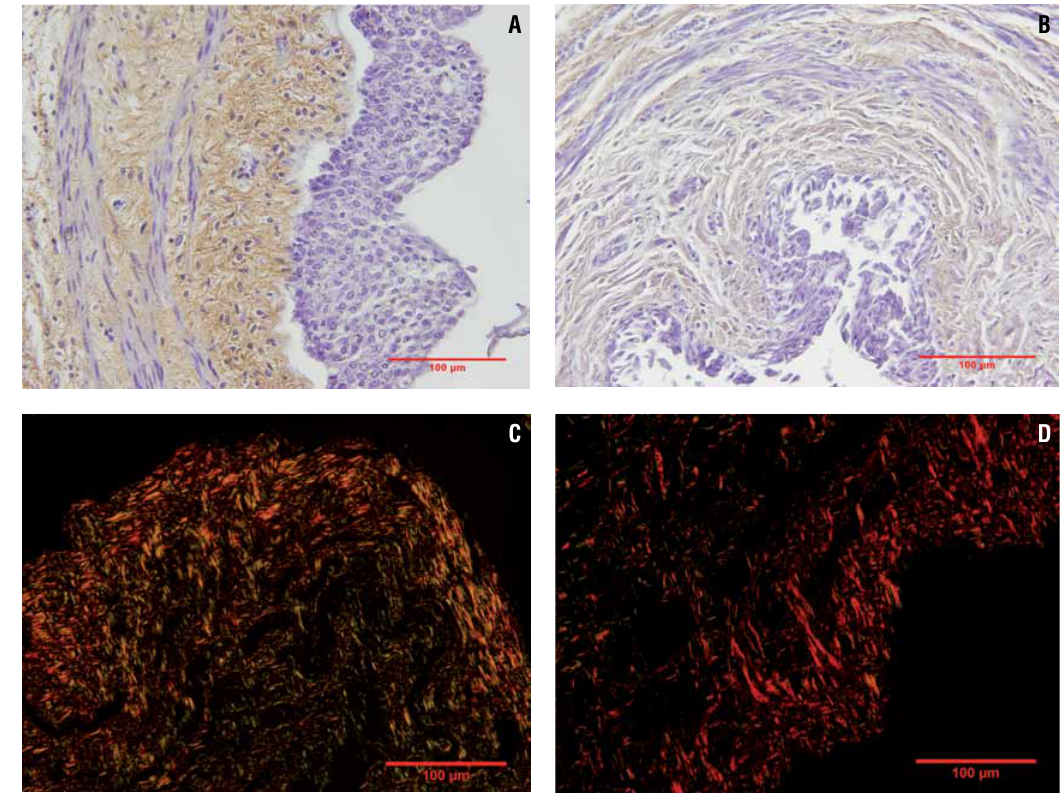
Figure 4 - Photomicrographs showing fetal ureter collagen. A) Immunohistochemistry showing type III collagen (brown) in a normal fetal ureter with 17 WPC. Anti-collagen type III antibody X400. B) Immunohistochemistry showing type III collagen (brown) in anencephalic fetal ureter with in a fetus with 16 WPC. Anti-collagen type III antibody X400. C) The photomicrograph shows predominance of green in normal fetal ureter, suggesting collagen type III presence in fetus with 27 WPC. Picro Sirius Red with polarization X400. D) The photomicrograph shows predominance of red in anencephalic fetal ureter, suggesting collagen type I presence in fetus with 30 WPC. Picro Sirius Red with polarization X400.